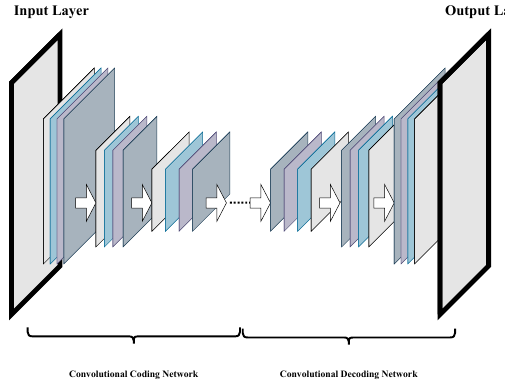
Figure 1. Schematic diagram of CAEN